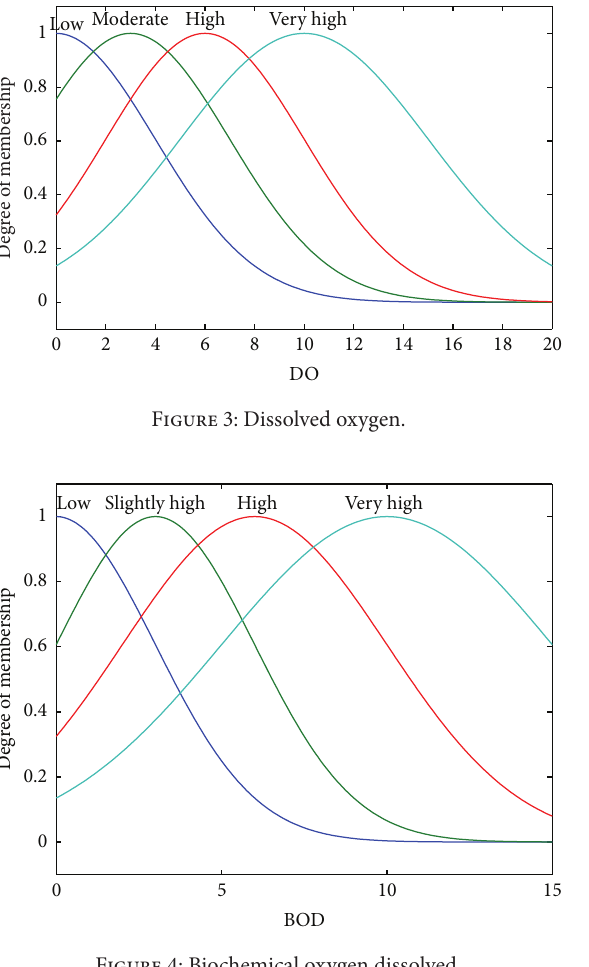
Figure 4: Biochemical oxygen dissolved.